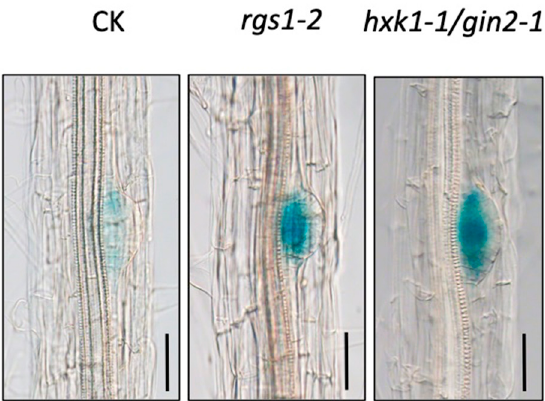
Figure 1. WOX7 expression increased in the hxk1 and rgs1 mutants, as indicated by the blue stain from the WOX7pro::GUS reporter gene. CK. WOX7pro::GUS in wild type Columbia background. Bars = 50 μ m. CK, wild type with the WOX7pro::GUS reporter gene. CK and mutants are all in Columbia background. The MS medium contains 1% sucrose, no glucose.